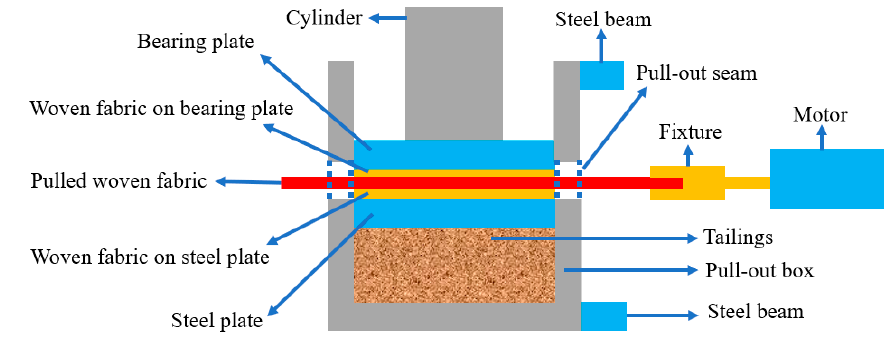
Figure 4. Schematic of the pull-out test.